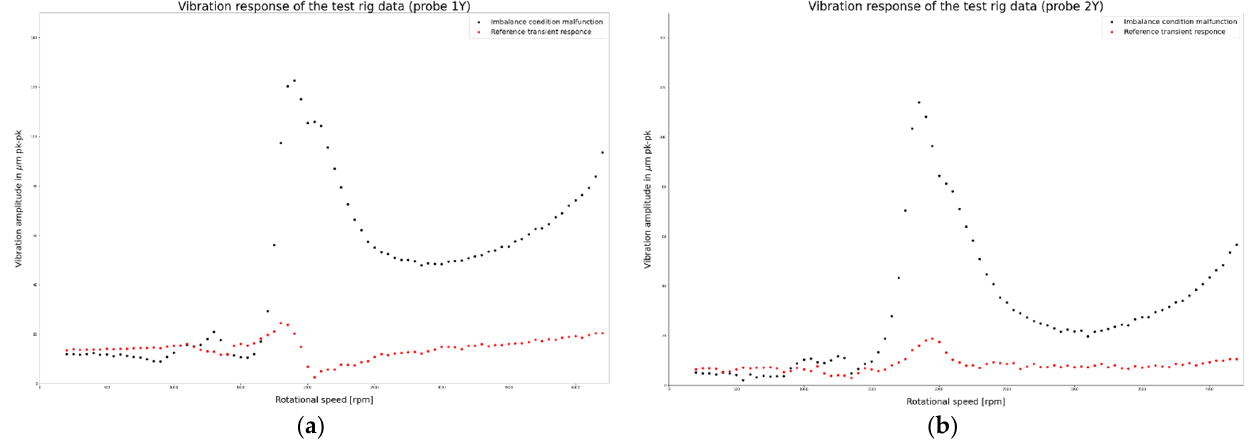
Figure 7. Test rig vibration response during the transient state with and without unbalance, respectively: ( a ) data from the bearing number 1; ( b ) data from the bearing number 2.